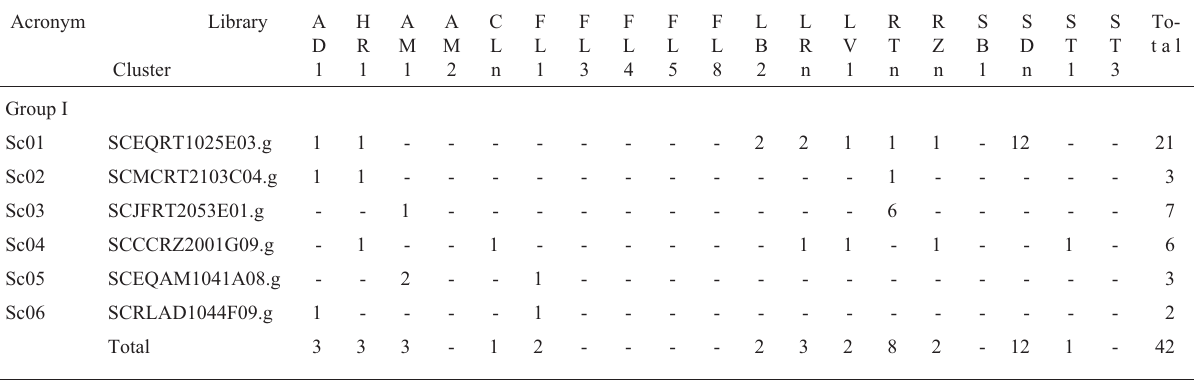
Table I - Frequency of sugarcane phytocystatin related reads and clusters in sugarcane cDNA